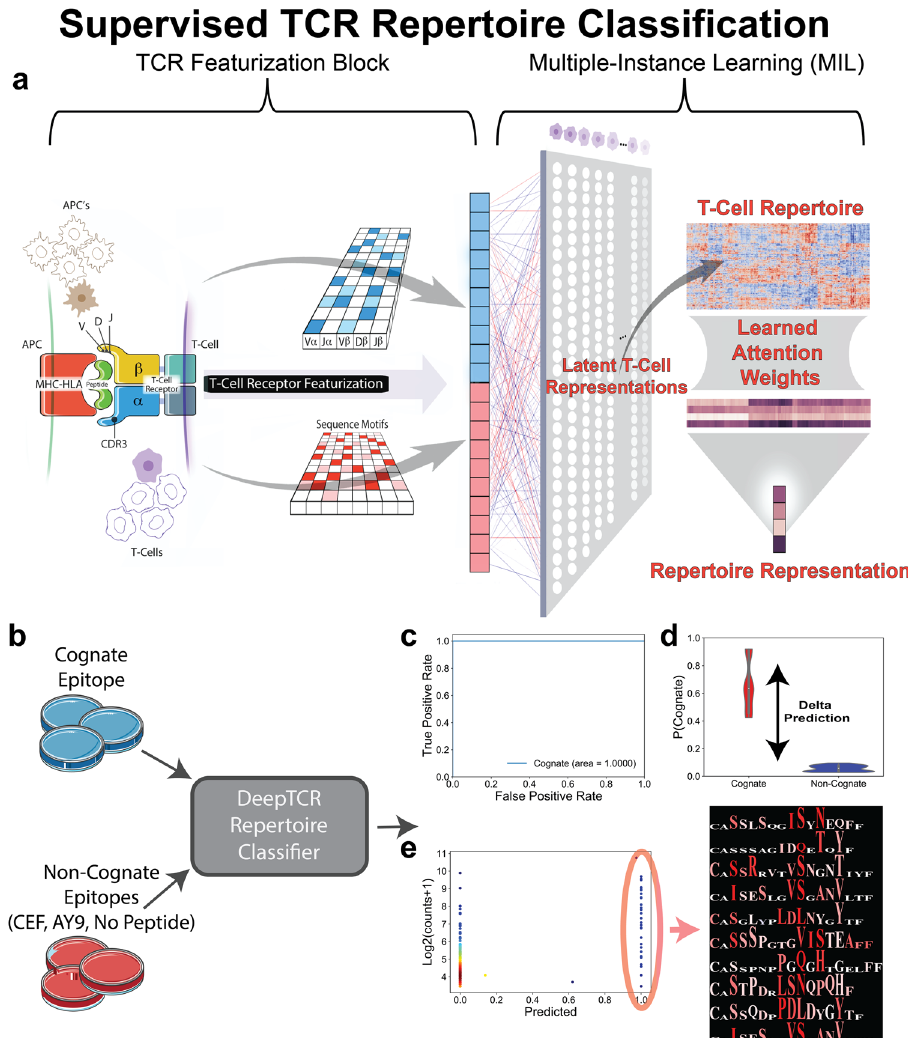
Fig. 4 Supervised TCR repertoire classi fi cation. a Multiple-Instance Learner (MIL) for classifying a TCR repertoire. Following previously described the TCR Featurization Block, we implement a multi-head attention mechanism to make sequence assignments to concepts within the sample. The number of concepts in the model is a hyperparameter, which can be varied by the user depending on the heterogeneity expected in the repertoires. Of note, this assignment of a sequence to a concept is done through an adaptive activation function that outputs a value between 0 and 1, allowing the network to put attention on the sequences that are relevant to the learning task. When taking the average of these assignments over all the cells in a repertoire, this results in a value within the neural network that directly corresponds to the proportion of the repertoire that is described by that learned concept. These proportions of concepts in the repertoire are then sent into a fi nal traditional classi fi cation layer. b In order to train TCR Repertoire Classi fi er on T Cell culture data, the model was given triplicates for the cognate epitope as well as non-cognate controls (CEF, AY9, No Peptide conditions). The model is trained to learn the distinguishing TCR sequence features of the cognate epitope from the controls through 100 Monte-Carlo simulations where the model is trained on two out of the three triplicates and performance is assessed on the left-out well for each set of conditions, ensuring that any predictions used for downstream interpretation have been obtained from data not used in training. c If the model is able to distinguish the cognate epitope from the controls with a high level of performance assessed by ROC, the epitope is considered to have elicited an antigen-speci fi c response. d The effect size of this response is then quanti fi ed by the difference in the magnitude of the average predictions for wells in cognate condition vs the average predictions for wells in the non-cognate or control conditions. e Following training of the model, sequence-level predictions can be obtained by running each TCR sequence in the cognate wells through the repertoire classi fi er allowing extraction of the antigen-speci fi c sequences from the background noise of the T cell culture. Residue Sensitivity Logos are shown for select antigen-speci fi c TCRs. Illustrations for panel a provided by Tim Phelps Copyright 2020 JHU AAM, Department of Art as Applied